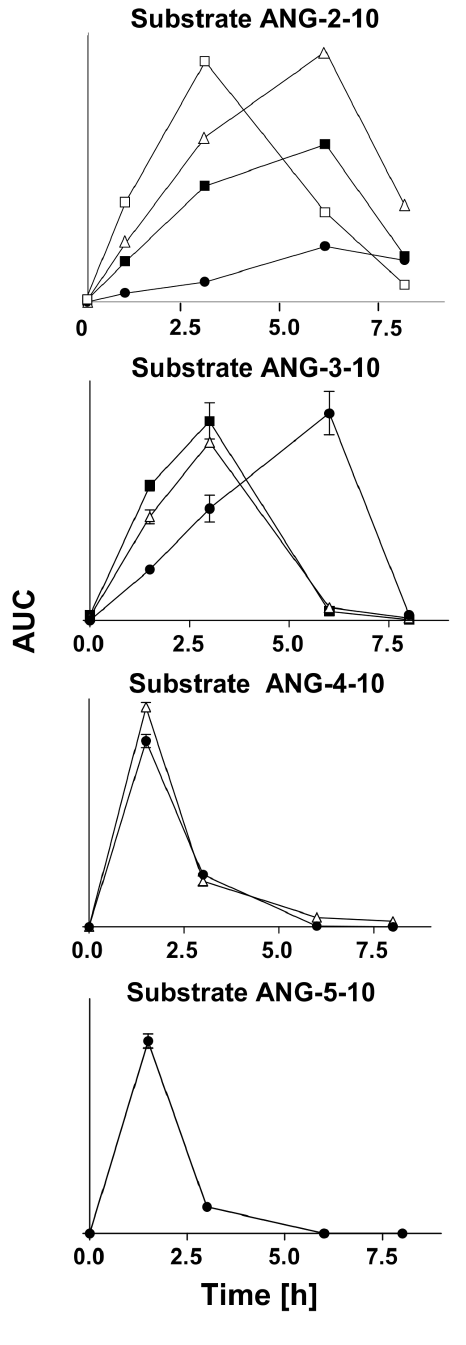
Figure 5. Processing of ANG-2-10, ANG-3-10, ANG-4-10 and ANG-5-10 by immobilized human plasma proteins. Each of these peptides was incubated with immobilized human plasma proteins. Reaction products were analyzed and relatively quantified by SRM-MS. The areas under the curves (AUC) of the generated angiotensin peptides ANG-3-10 (open square), ANG-4-10 (closed square), ANG-5-10 (open triangle), ANG-6-10 (closed circle) are shown (mean 6 SEM.). Aliquots were analyzed after 0 h, 2 h, 3 h, 6 h and 8 h (n=3, except for ANG-2-10 with n=1). doi:10.1371/journal.pone.0064027.g005 dissociated by the process of protein immobilization, since the peptides were also generated in non-immobilized undiluted and diluted human plasma (Figure 4). In comparison to non-